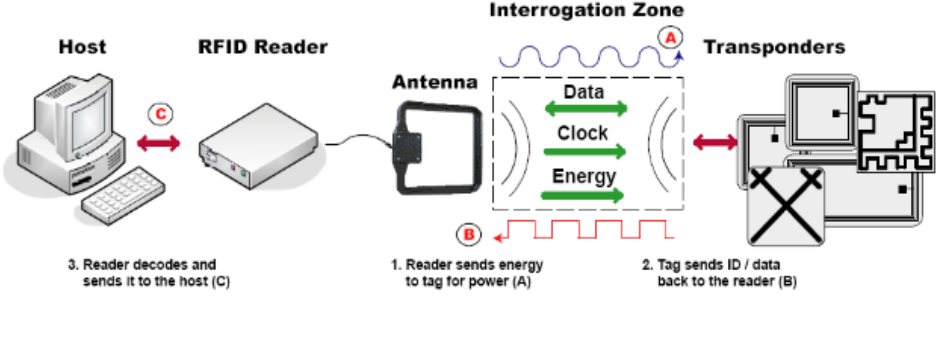
Fig. 1. RFID system components